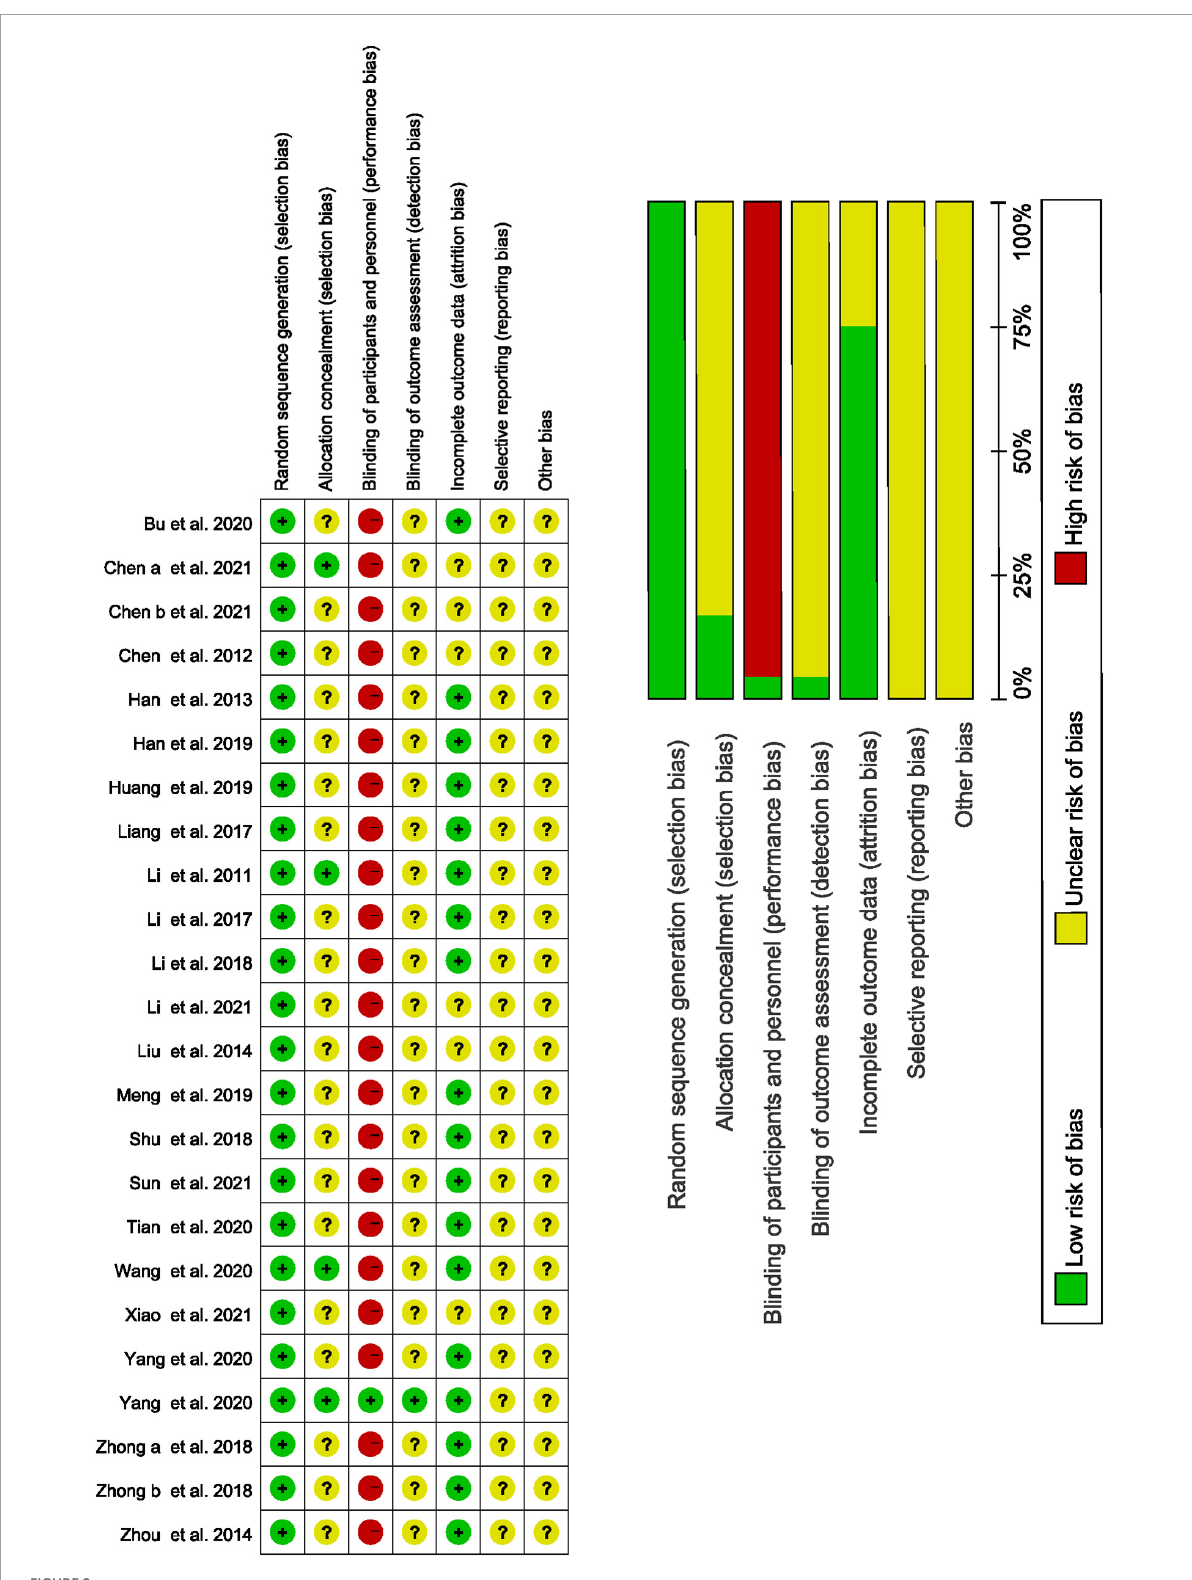
FIGURE2 Quality assessment of included